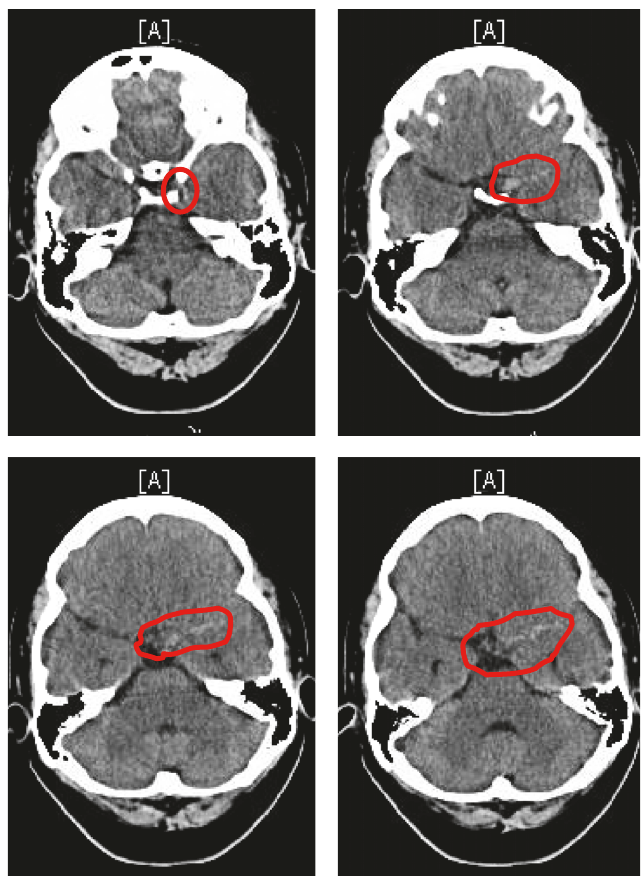
Figure 1: CT scan of brain without contrast axial view, on October 19, 2016, 15:51 PDT. There is mild density in the left horizontal fissure, as well as Sylvian fissure, consistent with a mild subarachnoid hemorrhage (red circles). No large acute infarction or other parenchymal lesions are